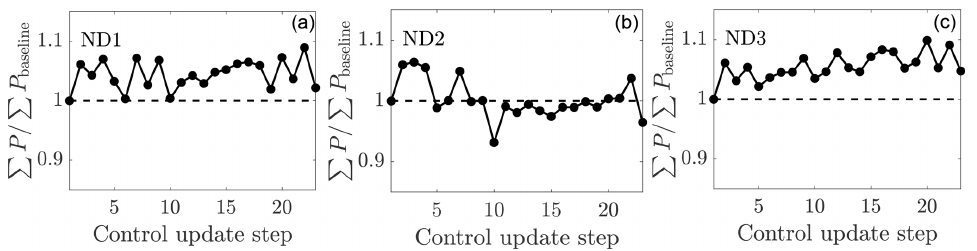
Figure 11. Time-averaged wind farm power production as a function of the control update steps for (a) online control using the initial parameters to initialize the next state (ND1), (b) online control using the previous optimal parameters to initialize the next state (ND2), and (c) the static state estimation control (ND3). The wind farm power is normalized by the power production of the aligned wind farm